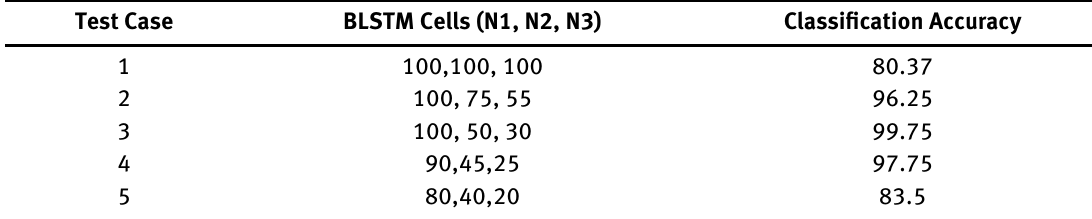
Table 3: Classification Accuracy under varying number of cells in three hidden layer for the proposed BLSTM